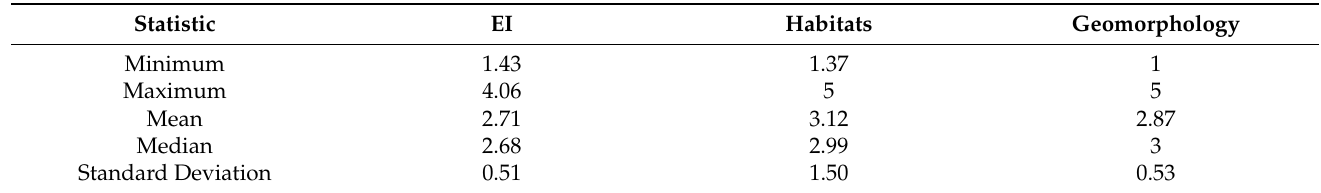
Table 3. Summary statistics of the Exposure Index (EI) and the two habitats and geomorphology sub-indices for the current climate period